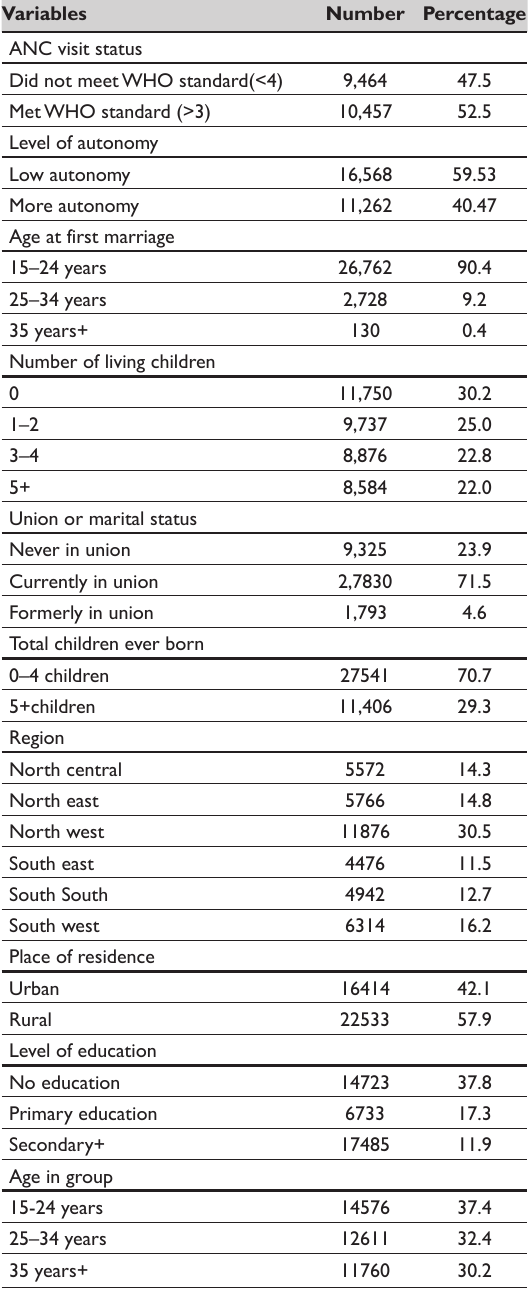
Table 2: Social demographic characteristics of Table 3: Relationship between participant’s